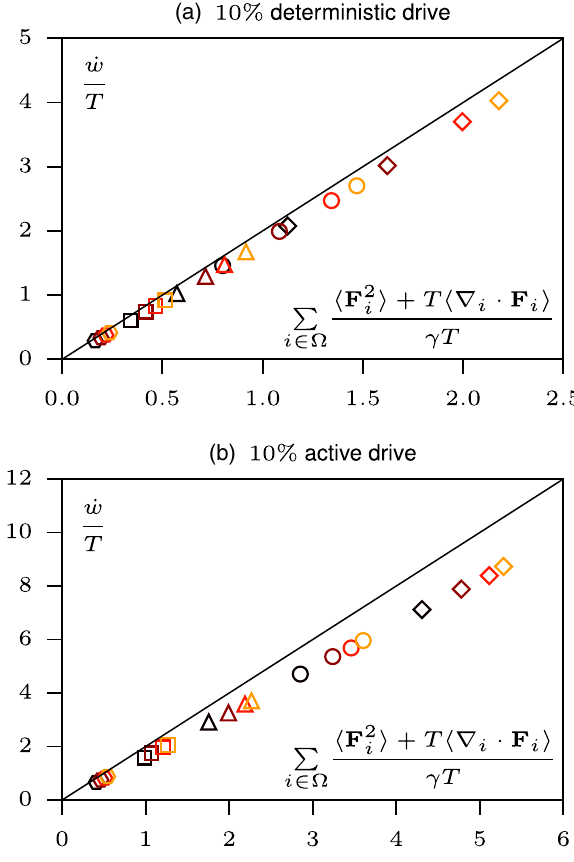
FIG. 2. Parametric plot of the rate of work _ w=T and of the P statistics of bath-tracer forces ½h F 2 i þ T h ∇ i · F i i(cid:2) = ð γ T Þ i ∈ Ω i when 10% of particles are driven by either (a) a deterministic force or (b) an active force. The solid line with slope 2 refers to the approximate relation (23). The satisfying agreement with numerical data indicates that the rate of work can be estimated by only measuring bath-tracer forces. The simulations are performed with N ¼ 4500 particles using the procedure described in Appendix A. Parameters: Pe ¼ 12 (hexagons), 18 (square), 24 (triangle), 30 (circle), and 36 (diamond); (a) τ T= ð γσ 2 Þ ¼ 2 × 10 − 1 (black), 3 × 10 − 1 (brown), 4 × 10 − 1 (red), and 5 × 10 − 1 (orange); (b) τ T= ð γσ 2 Þ ¼ 2 × 10 − 2 (black), 3 × 10 − 2 (brown), 4 × 10 − 2 (red), and 5 × 10 − 2